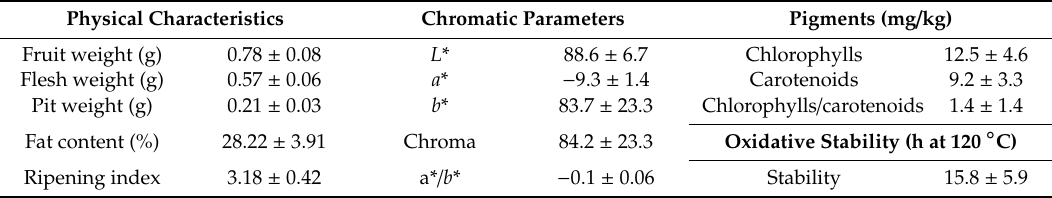
Table 1. Physical and chemical characterization of olive oil from ivory-white